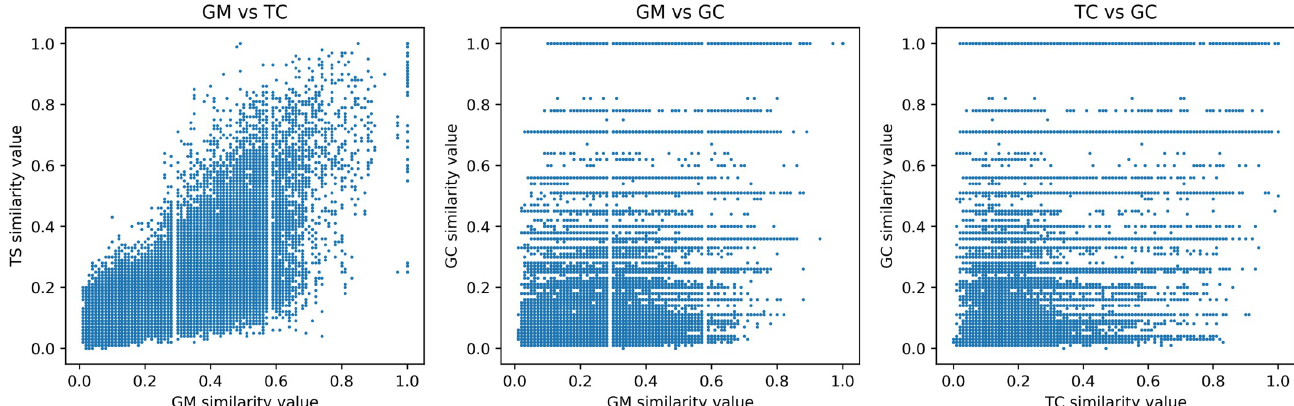
Fig 5. Correlation between (a) MG vs TC, (b) MG vs GC and (c) TC vs GC. We use M GC.